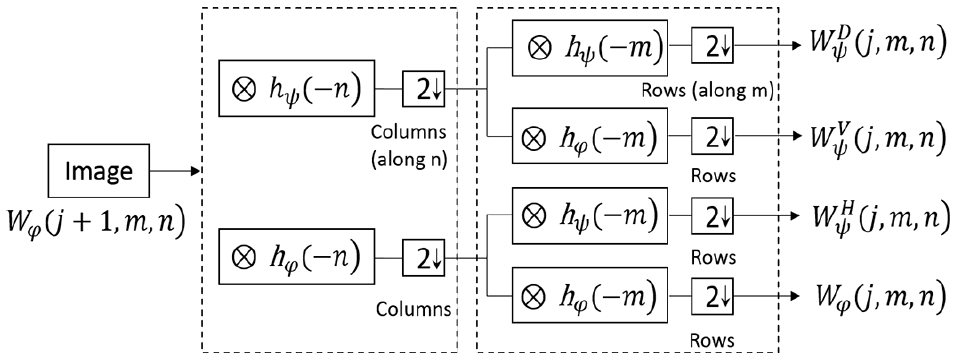
Figure 7. The 2-D DWT diagram for an image by using digital filters and down-sampling. An original 2-D image can be decomposed into four sub-image: a scaling component W ϕ and three wavelet components, W H , W D , and W V . In Figure 7, ⊗ denotes convolution symbol, h ψ denotes low pass filter, and h ϕ denotes high pass filter.